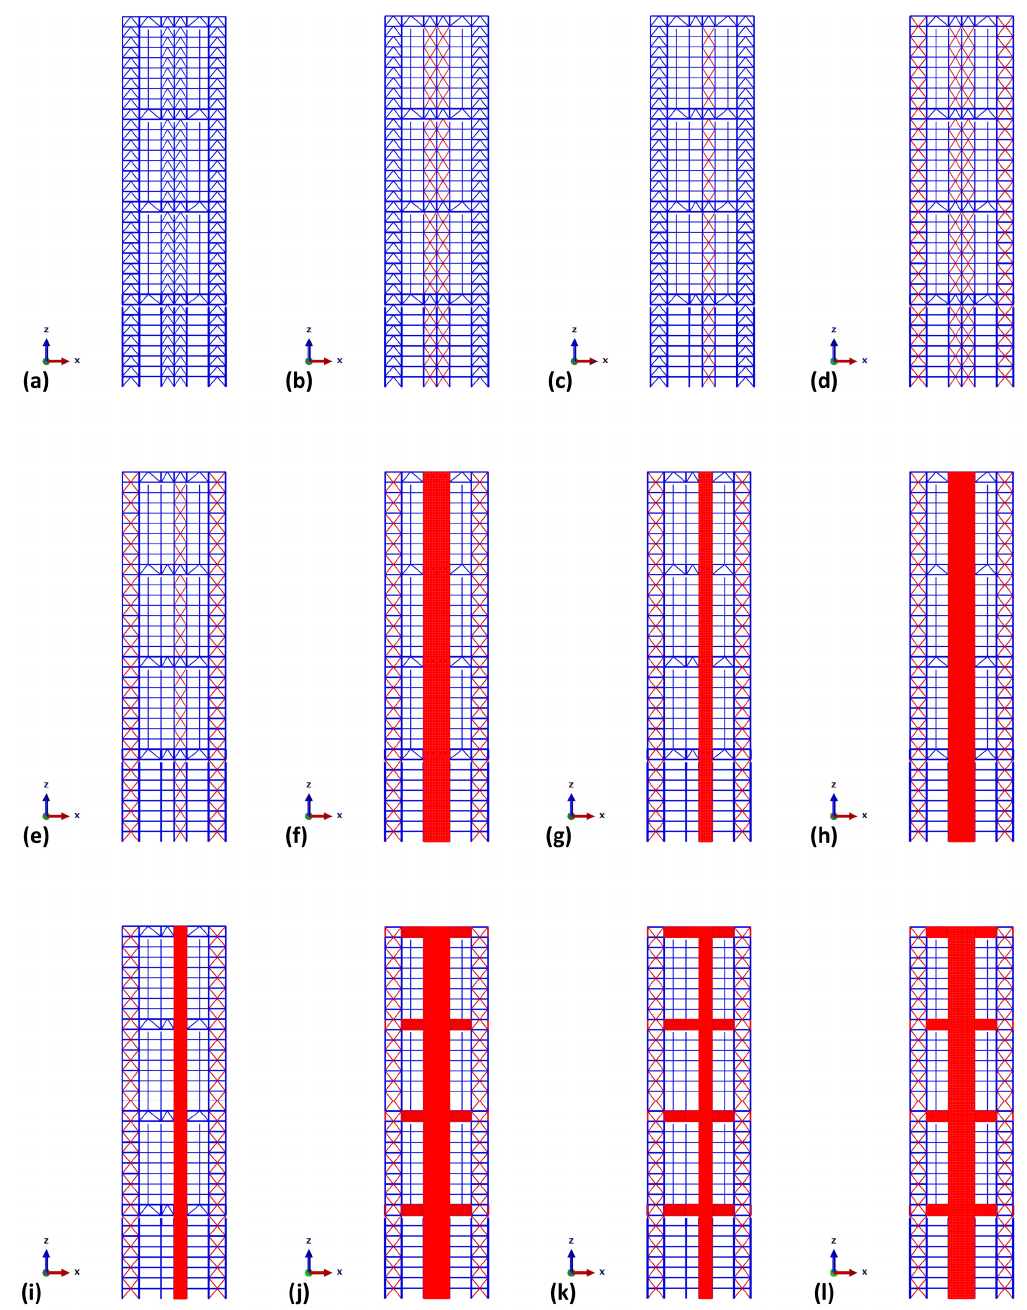
Figure C1. Structural configuration: ( a ) Conf. 1, ( b ) Conf. 2, ( c ) Conf. 3, ( d ) Conf. 4, ( e ) Conf. 5, ( f ) Conf. 6, ( g ) Conf. 7, ( h ) Conf. 8, ( i ) Conf. 9, ( j ) Conf. 10, ( k ) Conf. 11, and ( l ) Conf. 12 .